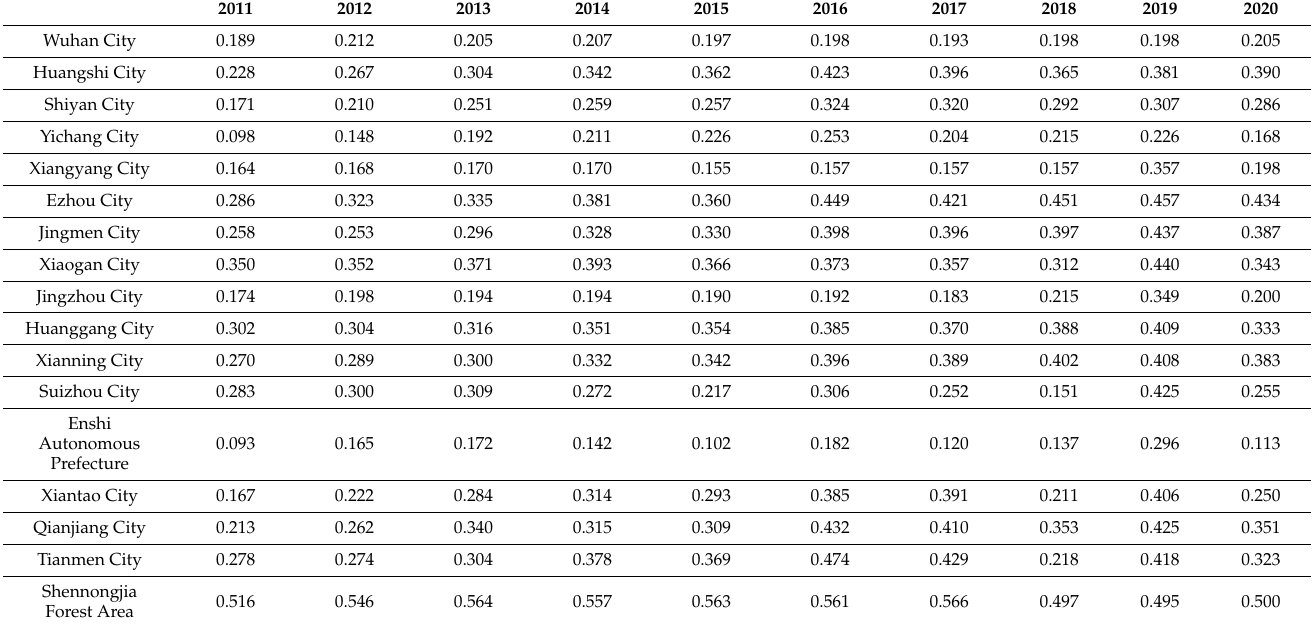
Table 4. Composite debt coefficient of prefecture-level cities in Hubei Province from 2011 to